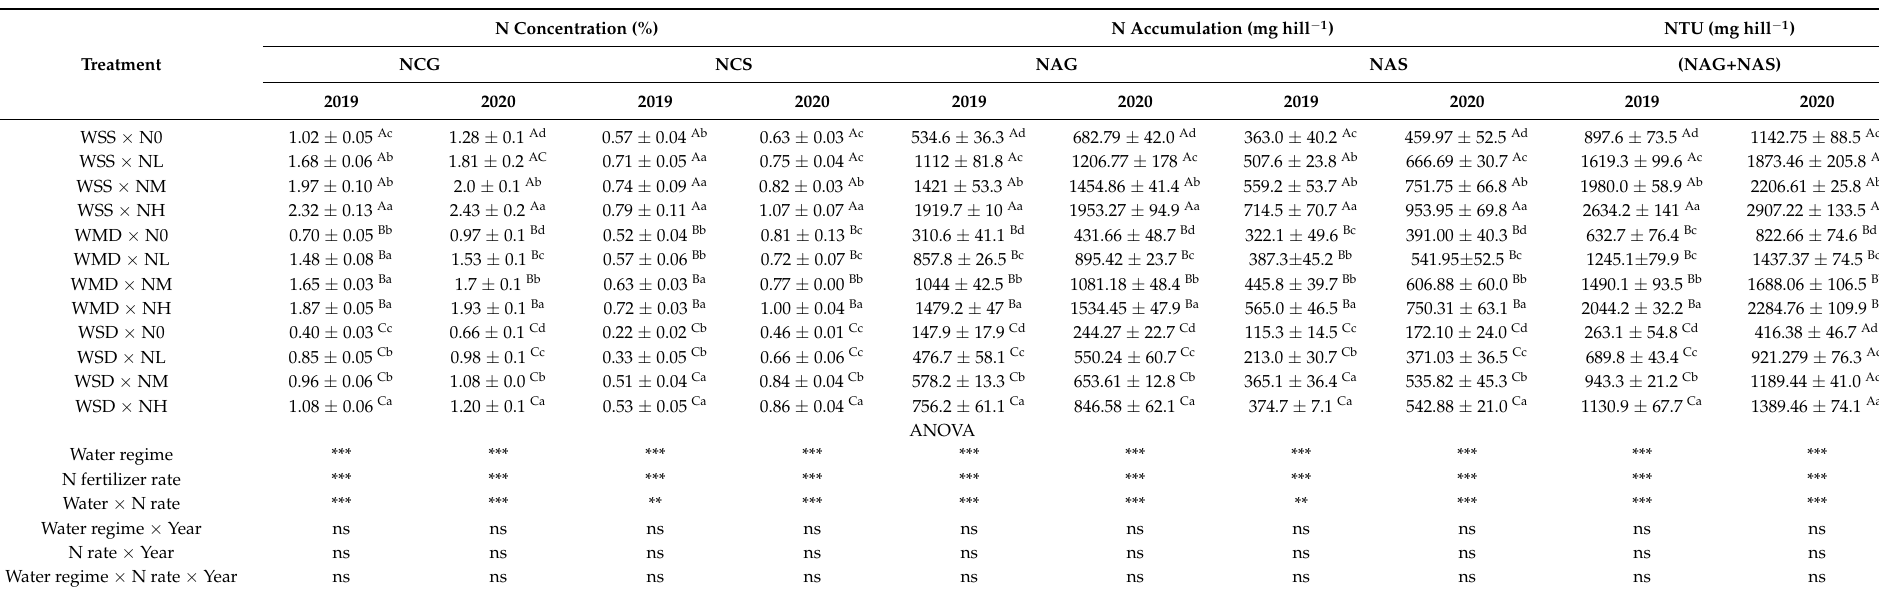
Table 4. Mean values of NCG, NCS, NAG, and NAS of rice plants for different irrigation methods and N fertilizer rates, and a summary of the ANOVA analysis of the effects of the irrigation method and N fertilizer rate on nutrient uptake in rice.